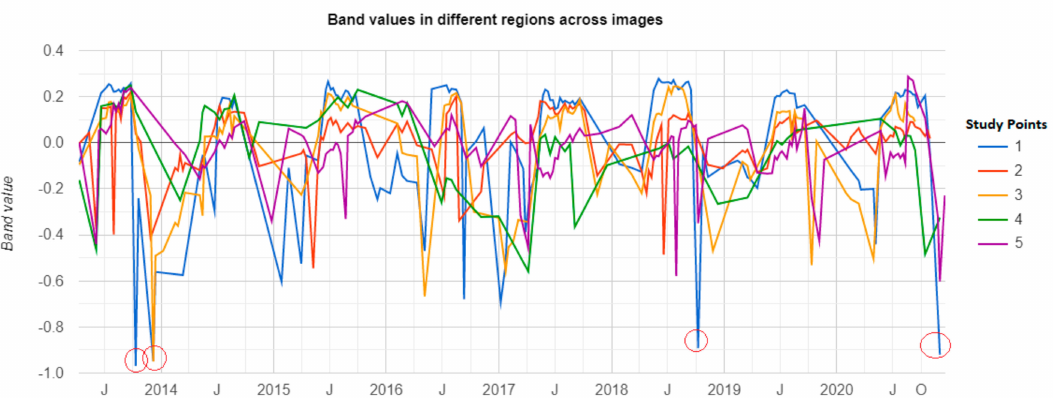
Figure 11. Time series of the MNDWI in five study points which are prone to flooding using Landsat 8 images in the Google Earth Engine (GEE).